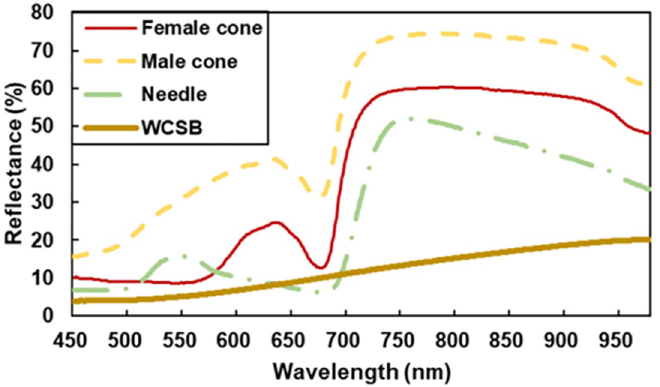
Fig 4. Spectral reflectance of pine plant organs and dead bodies of WCSB. Lines represent mean values.